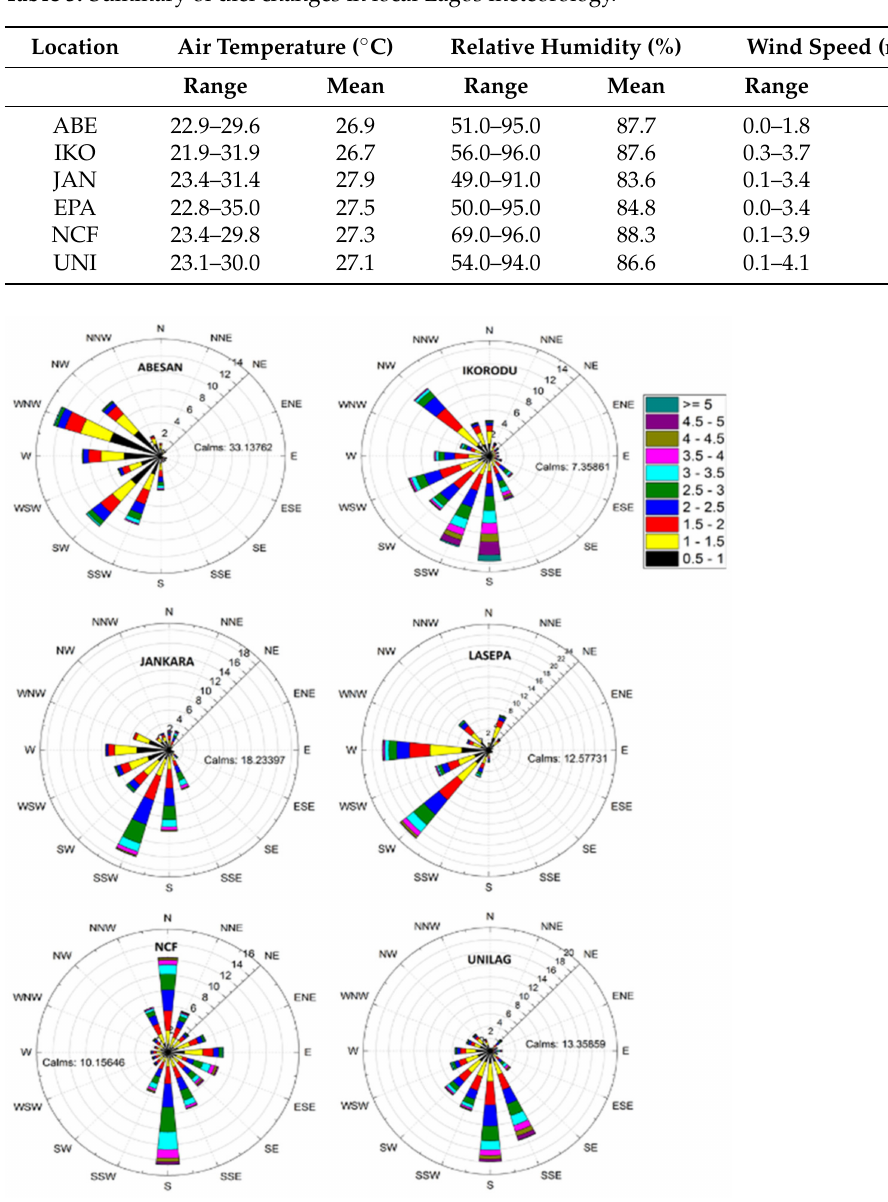
Figure 2. Surface (10 m height) wind roses for the Lagos monitoring sites. Color indicates wind speed range in